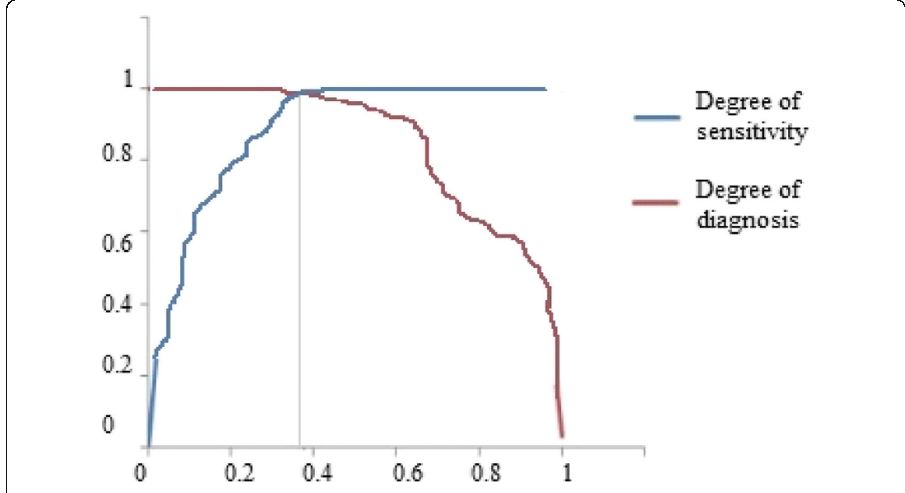
Fig. 21 The optimal threshold. The performance of the model is evaluated by two indicators: 1) Degree of sensitivity: A proportion of bad customers that the model classifies in a bad customer group. 2) The degree of diagnosis: A proportion of well-off customers that the model classifies in a good customer group. In order to judge customers and group them into low risk, medium risk, and high-risk customers, the probability of default within the interval [0, 1] was determined. If the probability of defaults were on more than one point, the customer was considered with a high risk and less than that means the customer is low risk. In this paper, the optimal threshold limit equals a value that maximizes the degree of sensitivity and the degree of diagnosis of the model. This Fig shows that the optimal threshold (Y) of the degree of sensitivity and degree of detection is 0.37. The blue line is the degree of sensitivity and the red line is the degree of